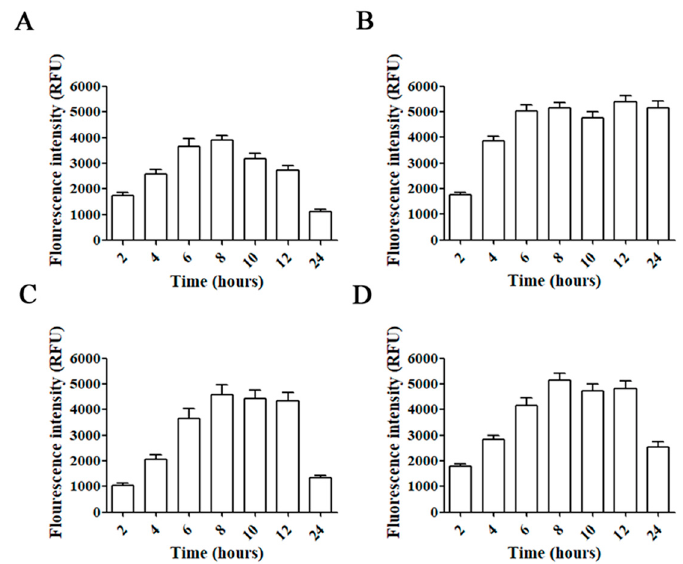
Figure 2. Time-courses for uptake of AMC6 / Alexa Fluor 488-labeled siRNA complexes. C6 ( A ), U87 ( B ), GL261 ( C ) and T98G ( D ) cell lines were treated with AMC6 / Alexa Fluor 488-labeled siRNA complexes (1 µ M / 100 nM) for 2, 4, 6, 8, 10, 12 and 24 h. Fluorescence intensity inside the cells was determined by selecting regions of interest. Data are expressed as the average ± SEM ( n = 50).